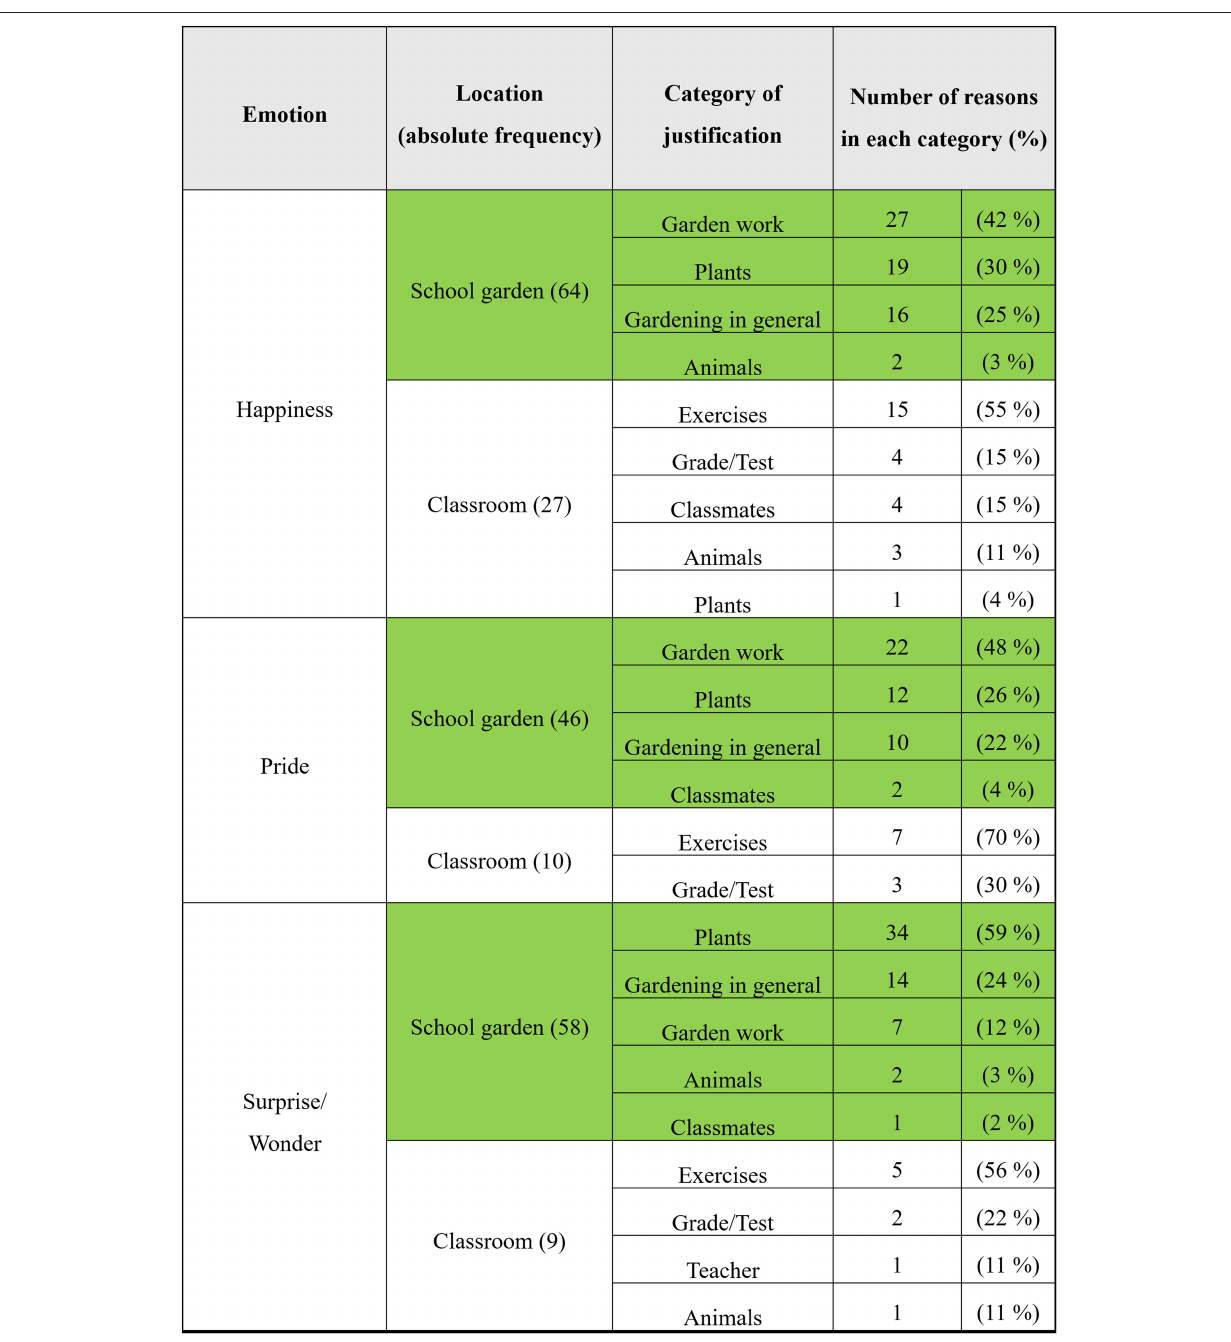
FIGURE 6 | Reasons of positive emotions (school garden n = 223; classroom n =